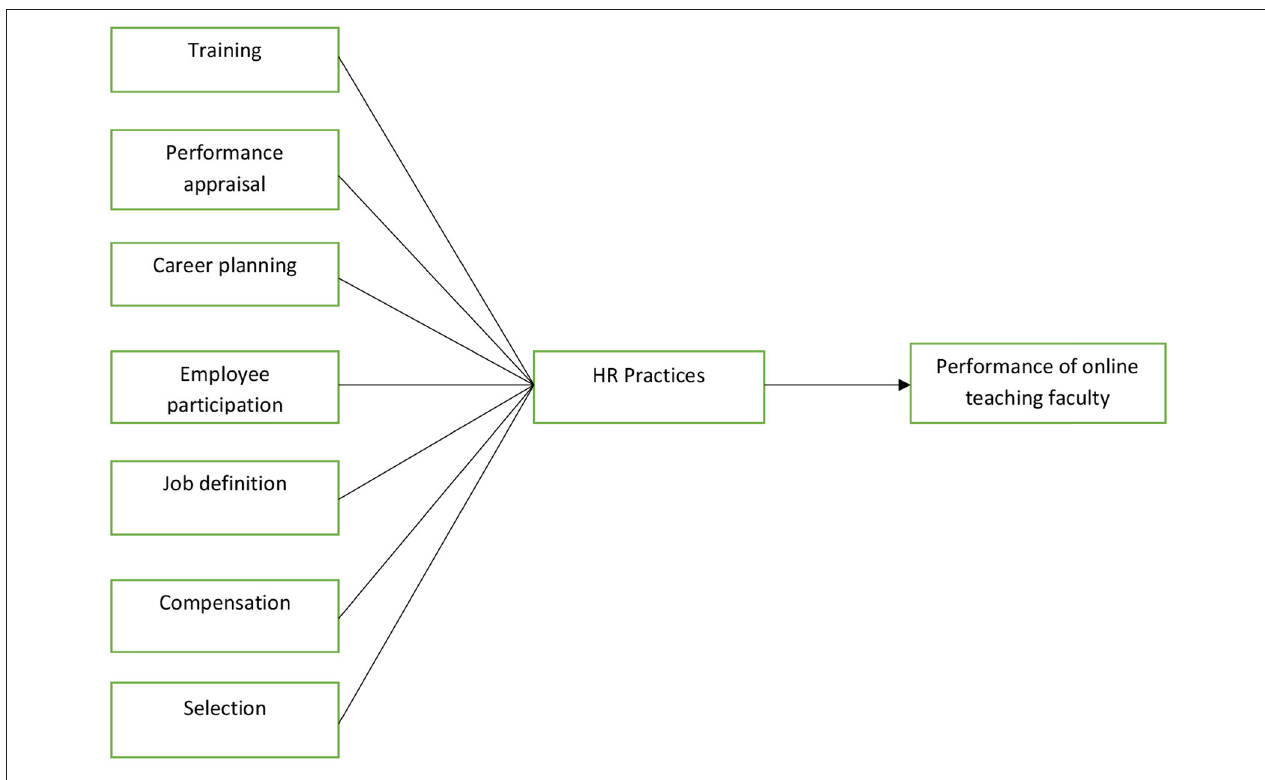
FIGURE 1 | Theoretical framework.